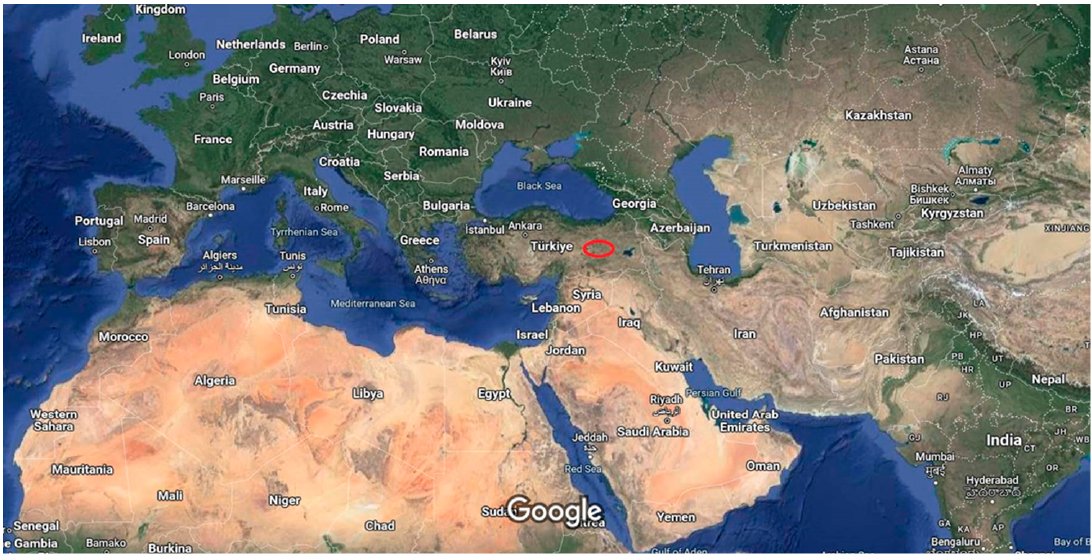
Figure 1. Map of the collection sites of the study area (Source: Google). The red zone represents the working area.